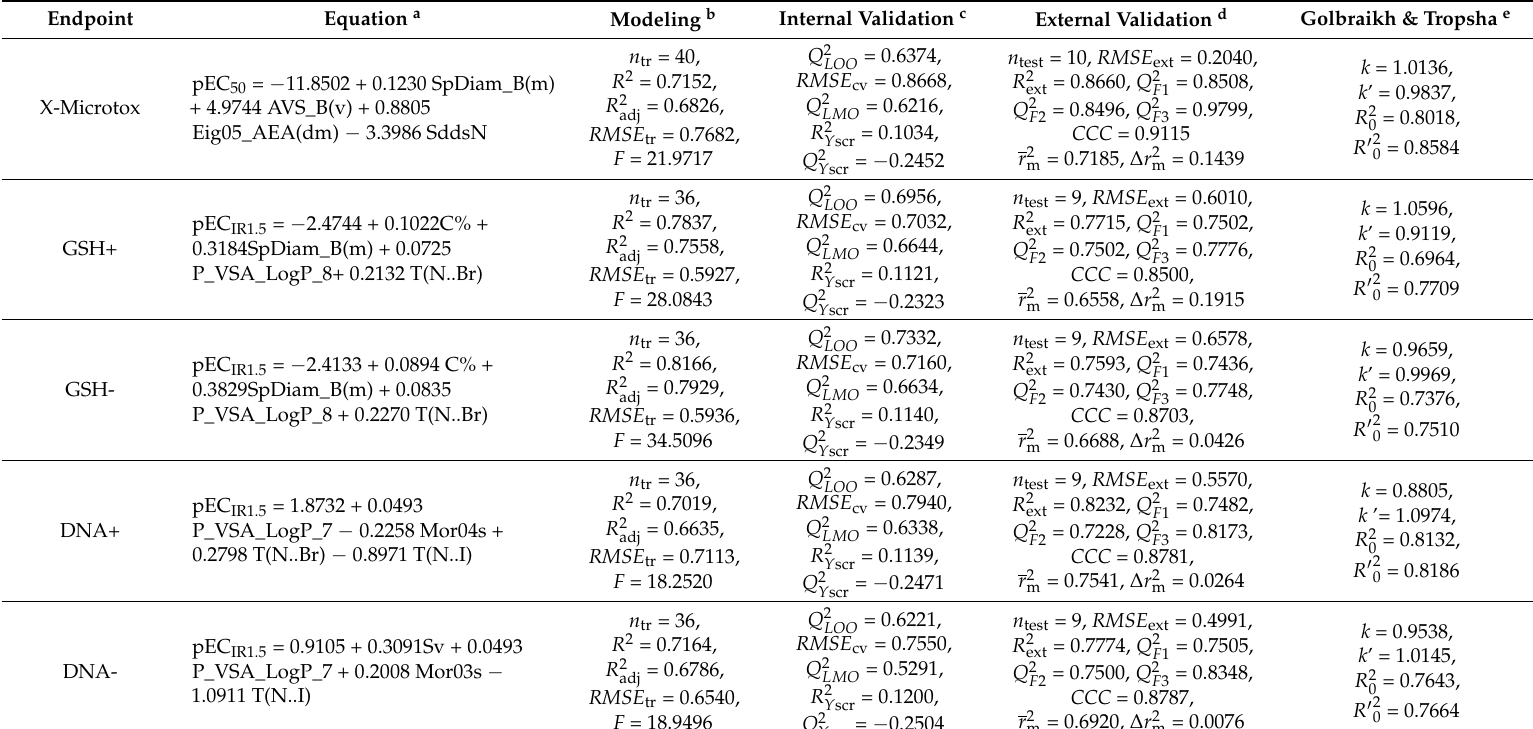
Table 3. QSAR(quantitative structure–activity relationship) model and statistical parameters for five endpoints of disinfection byproduct (training set = 80% of whole dataset, test set = 20% of whole